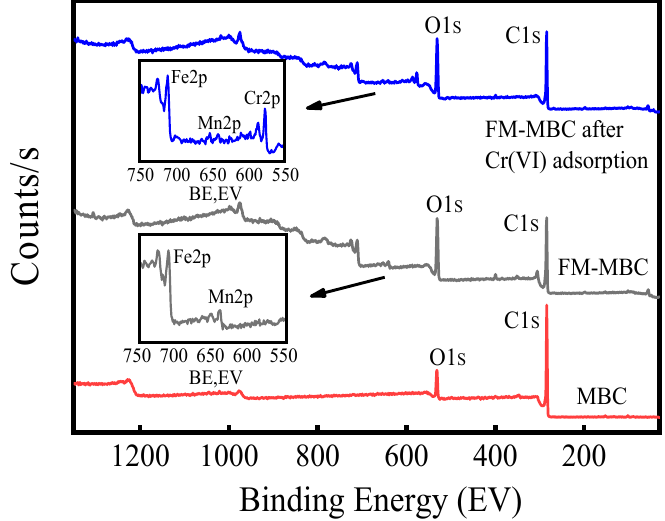
Figure 9. XPS of a full scan spectrum of MBC, FM-MBC and FM-MBC after Cr(VI) adsorption.